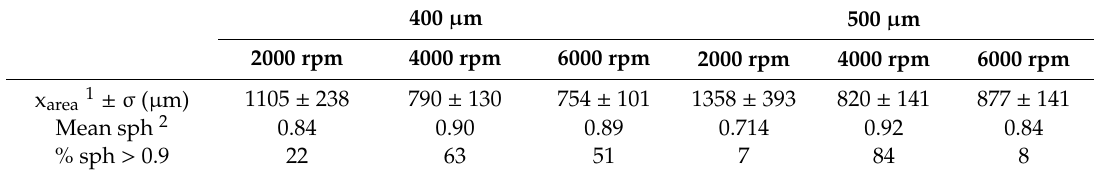
Table 2. Particle size distribution of particles (CamSizer ® measurements) processed by nozzle diameters of 400 and 500 µ m and using 40-wired cutting disc velocities of 2000, 4000, and 6000 rpm.